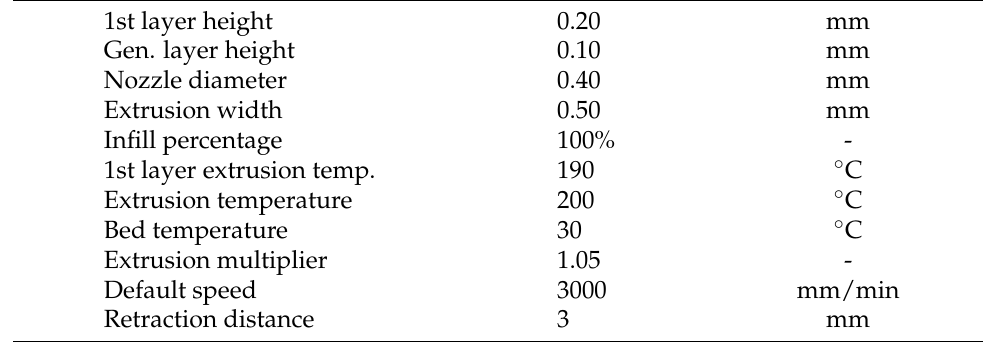
Table 6. Printing parameters used for specimen production in the characterization